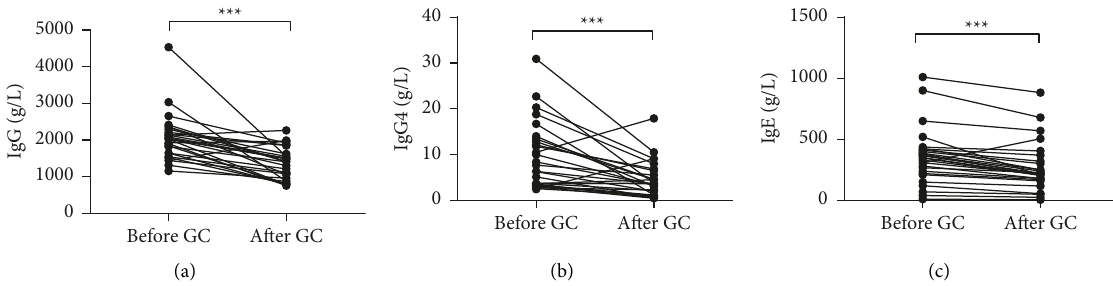
Figure 5: Immunoglobulin indices before and after glucocorticoid therapy in patients with IgG4-RD combined with abnormal liver function and elevated serum